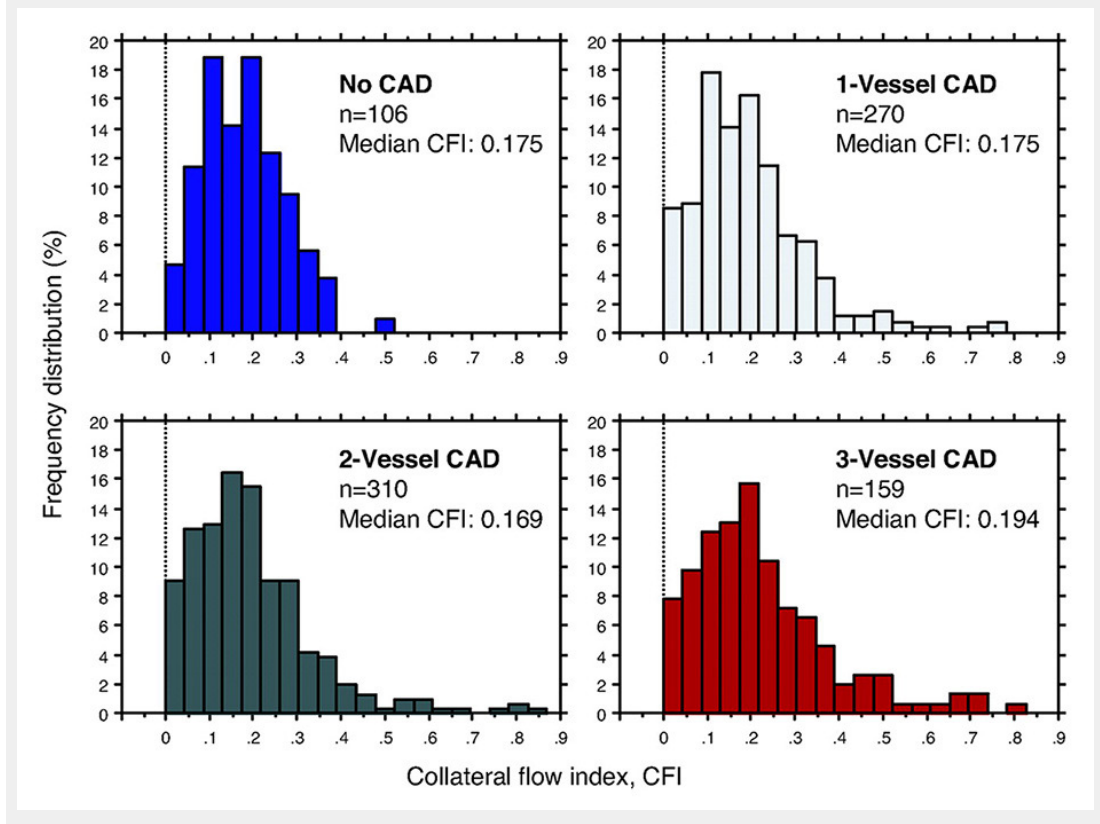
Figure 2 Frequency distribution (vertical axes in percent) of collateral flow index (CFI, horizontal axes) in patients without coronary artery disease (CAD; top left) and with increasing severity of CAD. Sufficient collaterals by CFI are present in a fourth of patients with angiographically normal coronary arteries, whereas this proportion increases to one third in patients with CAD. (Data from Meier P, et al. Beneficial effect of recruitable collaterals: a 10-year follow-up study in patients with stable coronary artery disease undergoing quantitative collateral measurements. Circulation. 2007;116:975–83 [40], with